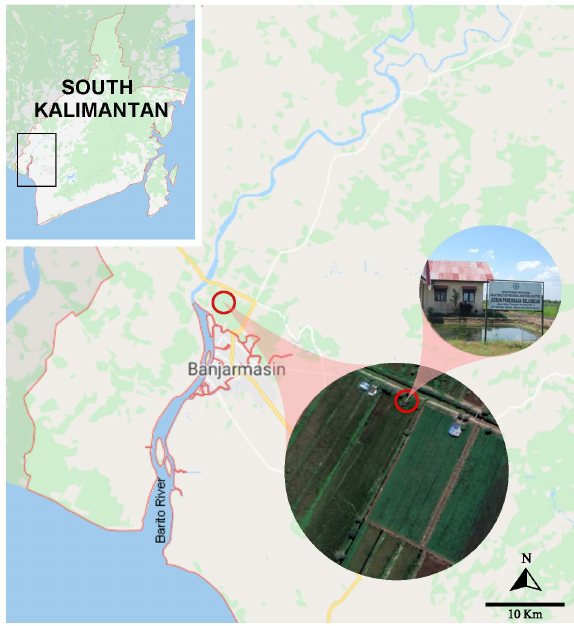
Figure 2. Map showing the location of the ex-situ conservation site for Indonesian swamp rice germplasm at the ISARI Research Station (red circle; 3º 10ʹ 15.77ʺ S, 114º 36ʹ 12.34ʺ E).